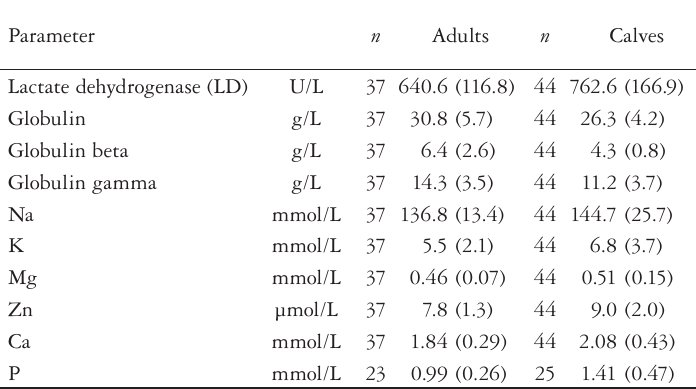
Table 4. Differences in serum biochemical parameters between adults and calves ( P < 0.01). Mean values are shown with standard deviation. Parameter n Adults n Calves Lactate dehydrogenase